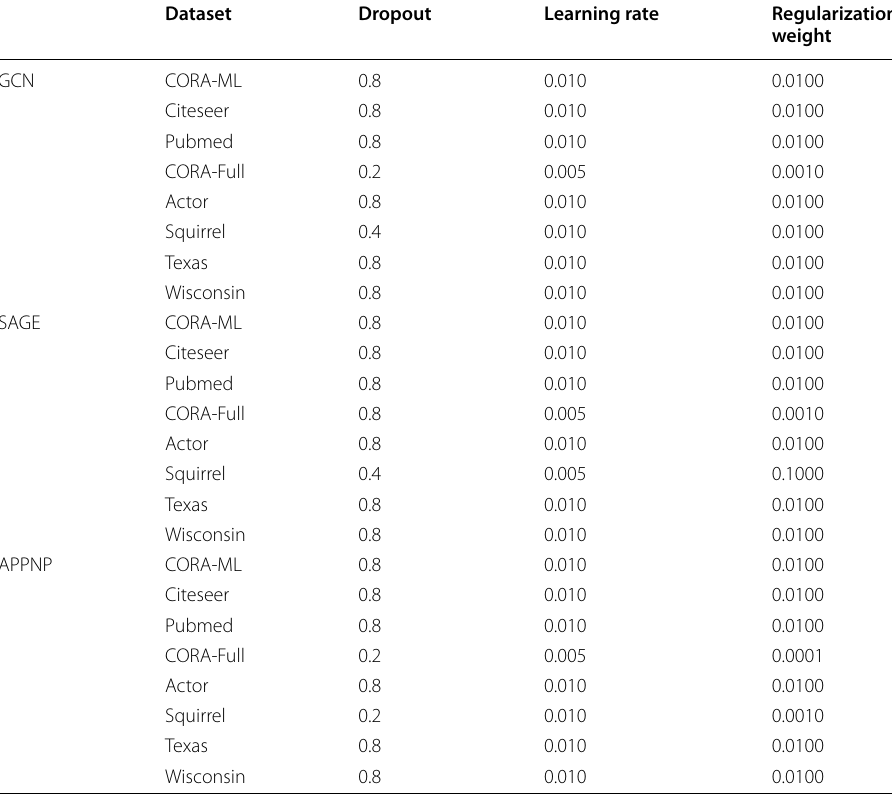
Table 5 Chosen hyperparameters for all GNN models except